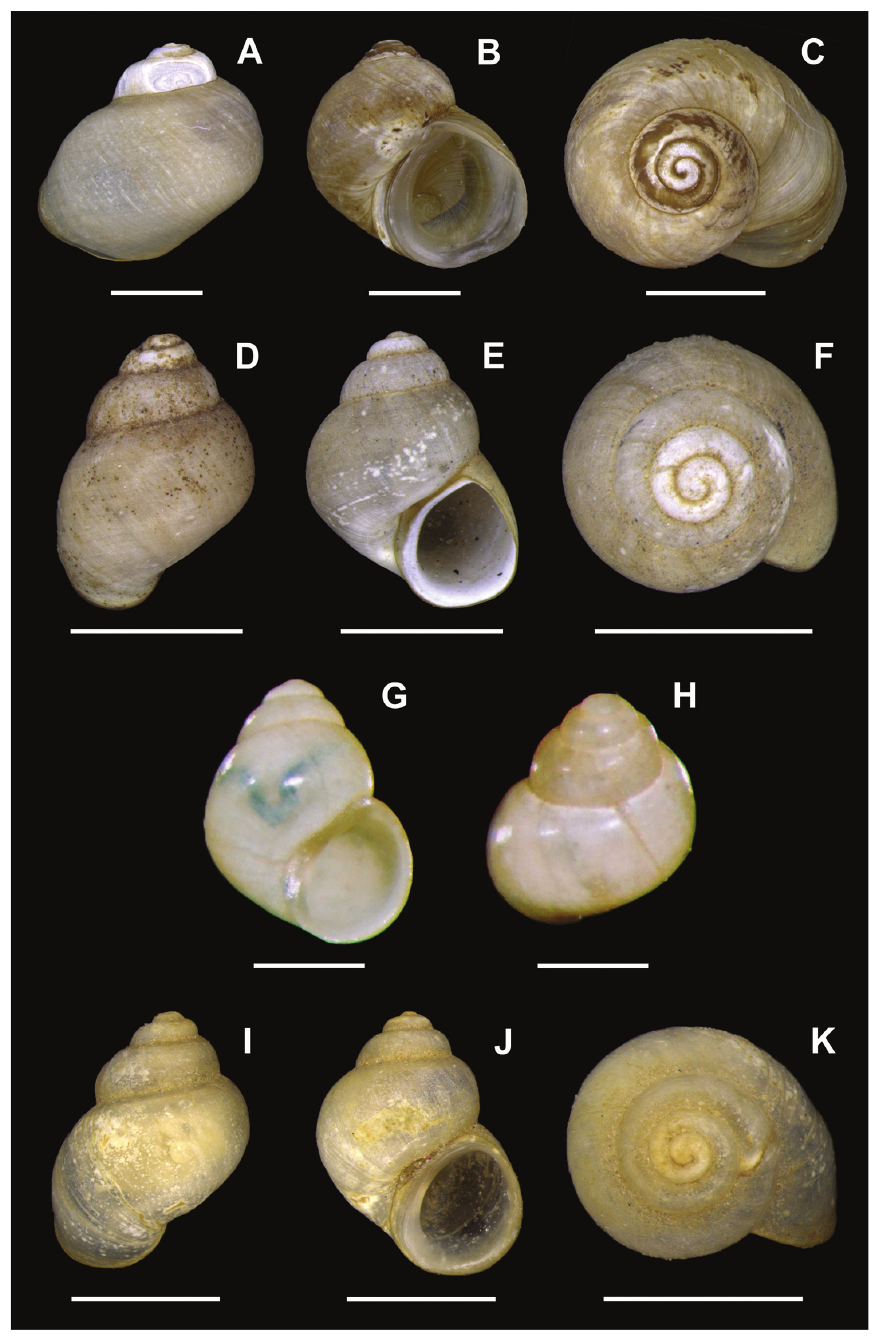
Figure 8. Potamolithus sp. 9 A (dorsal view) B (apertural view) C (apical view); Potamolithus sp. 10 D (dorsal view) E (apertural view) F (apical view); Potamolithus sp. 11 G (dorsal view) H (apertural view); Potamoli- thus sp. 12 I (dorsal view) J (apertural view) K (apical view). Scale bars: 1mm. (Photographs: LBR